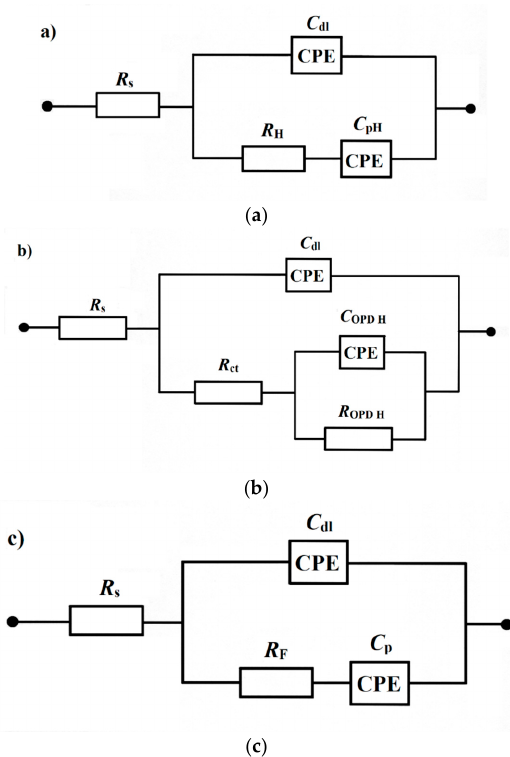
Figure 3. ( a ) Equivalent circuit for UPD of H adsorption process, exhibiting Faradaic pseudocapacitance, C pH , charged via a Faradaic resistance, R H , in a parallel combination with the double-layer capacitance, C dl (both capacitance parameters are CPE: constant phase element-modified), jointly in series with an uncompensated solution resistance, R S and ( b ) two CPE-modified C - R element equivalent circuit used for fitting the HER impedance data recorded on Pt electrode surface. The circuit includes R ct and C dl elements corresponding to the HER charge-transfer resistance and double-layer capacitance components, and R S is solution resistance; R OPD H and C OPD H elements correspond to the resistance and capacitance components of the so-called OPD H: overpotentially deposited hydrogen species; ( c ) equivalent circuit used for fitting the impedance data for the reversible process of AcN oxidation on Pt electrode surface, where R F and C p (CPE-modified) elements correspond to the Faradaic charge-transfer resistance and distributed pseudocapacitance, C dl (also reported as CPE) to interfacial double-layer capacitance and R S is solution resistance. In the impedance spectra, the process of UPD of H gave rise to a semicircle observable throughout the high and intermediate frequency range of the Nyquist plot along with a vertical line characterizing purely capacitive (although it often deviates from a 90° angle due to a capacitance dispersion effect) behavior at sufficiently low frequencies (Figures 2a and 3a). Hence, in the present work, the recorded results on the kinetics of the UPD of H process (see Table 1) follow in general other literature-available data [27–31]. Thus, over the potential range 100–200 mV/RHE, the double- layer capacitance values, C dl for poly Pt electrode fluctuated around 20–70 μ F·cm − 2 . The H adsorption pseudocapacitance, C pH changed (decreased) with increasing potential in a similar way to the current–density changes in the CV profiles of Figure 1a. Then, the corresponding charge-transfer